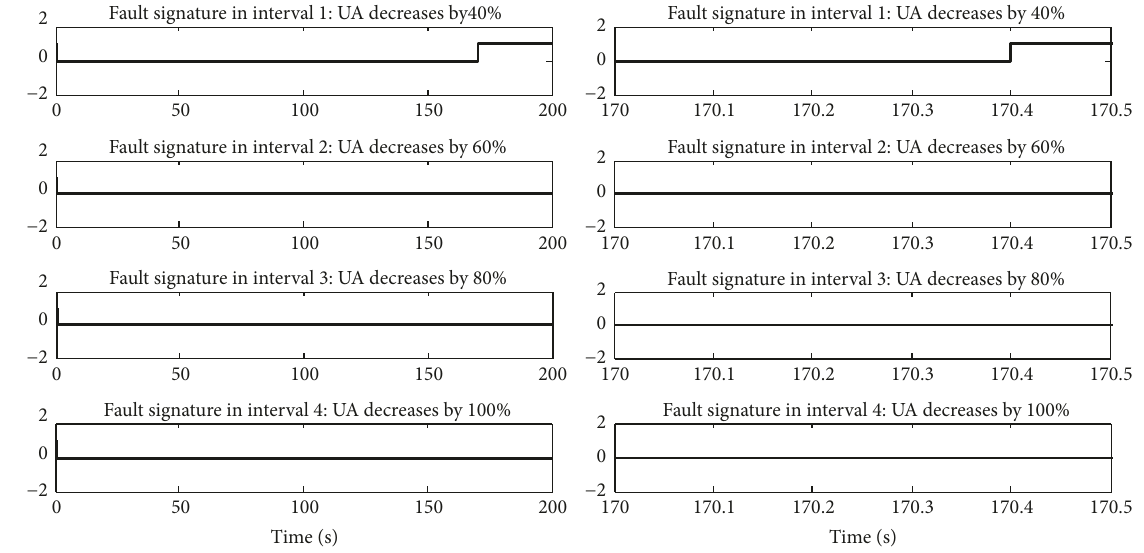
Figure 18: Fault signature sent by parameter filters of overall heat transfer coefficient UA.